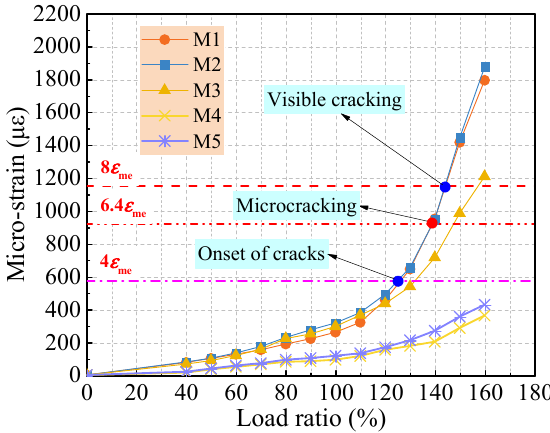
Figure 14. The load-strain relationship of the mortar.